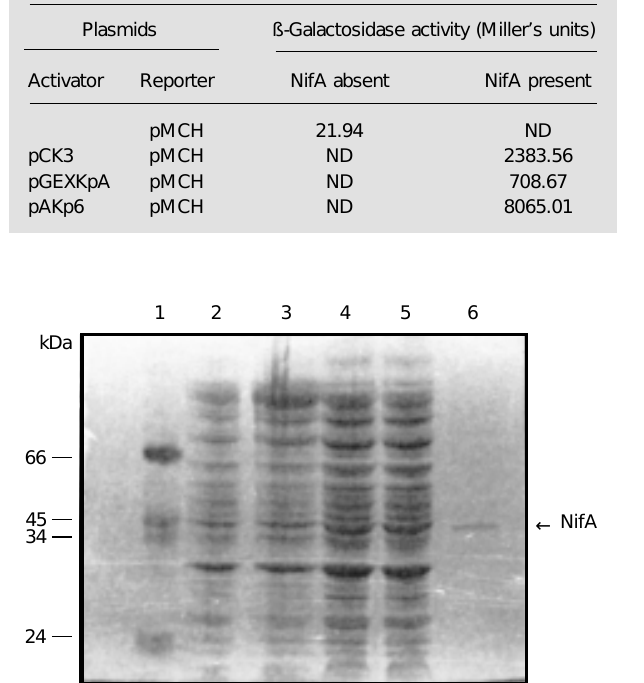
Table 3 - Activation of nifH promoter by K. pneumoniae NifA in an E. coli background.